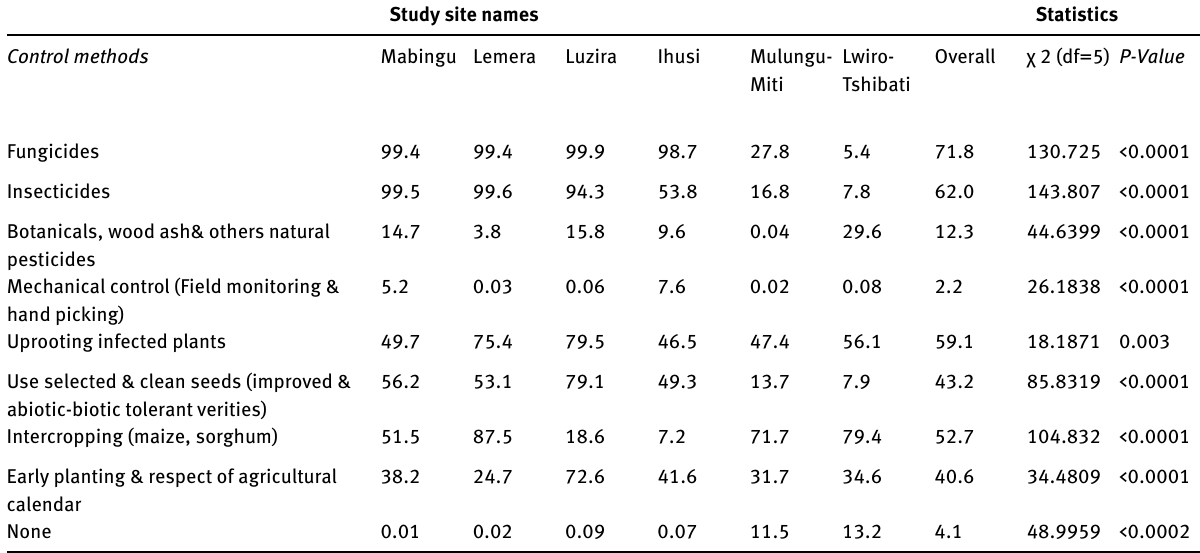
Table 6: Insect pests and disease control methods as practiced by farmers interviewed (Data are % responses; n = 300 respondents)